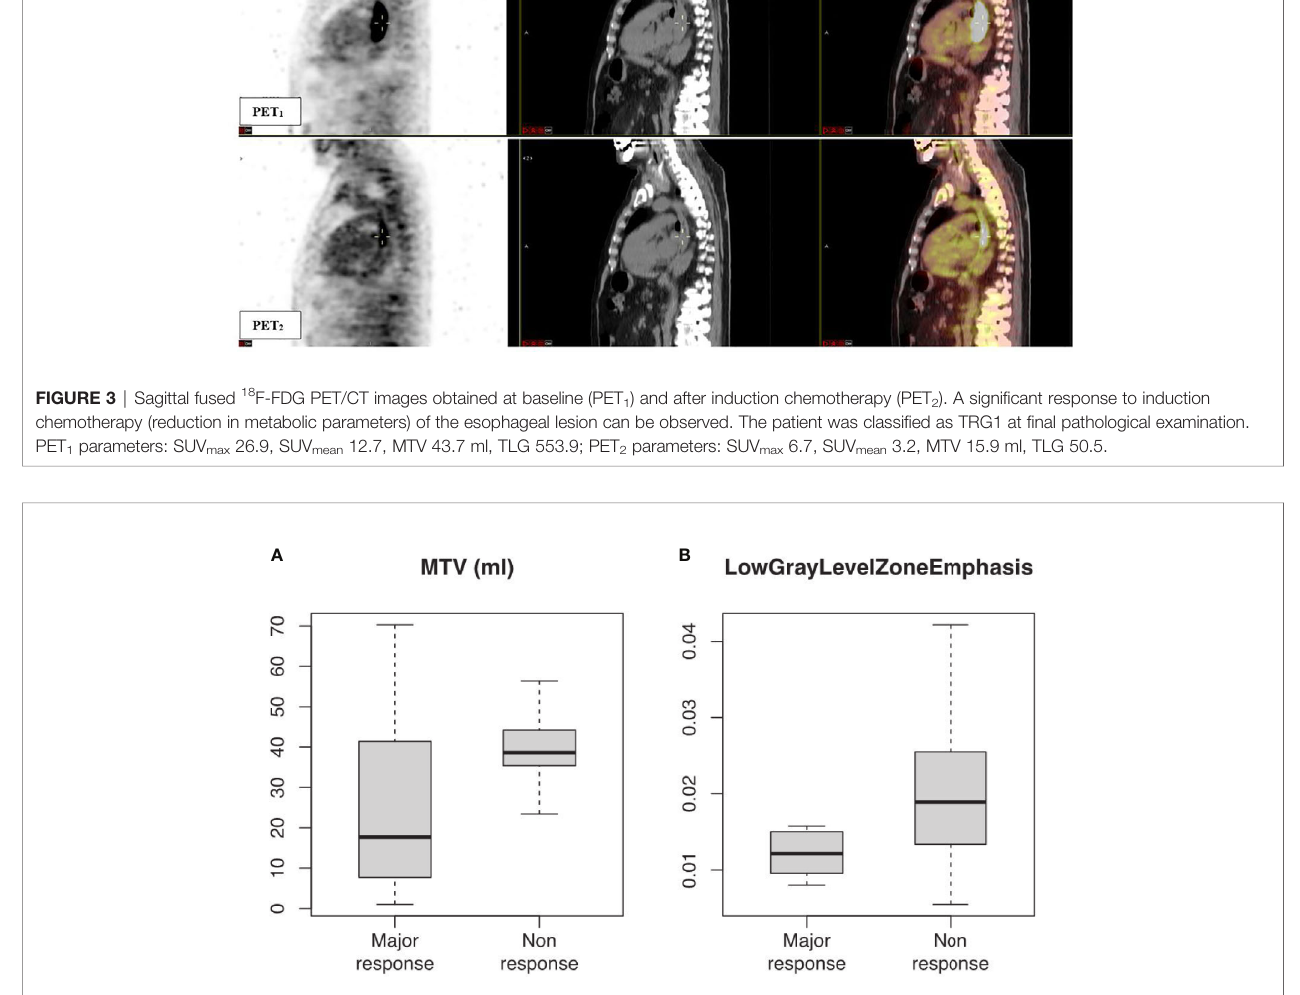
FIGURE 4 | Boxplot distribution of (A) MTV (ml) and (B) LowGrayLevelZoneEmphasis (GLCM) radiomic feature at 18 F-FDG PET/CT scan taken before induction chemotherapy (PET 1 ). Classes are divided between major (TRG1-2) and non (TRG3-4) response (median, interquartile and full range are displayed).